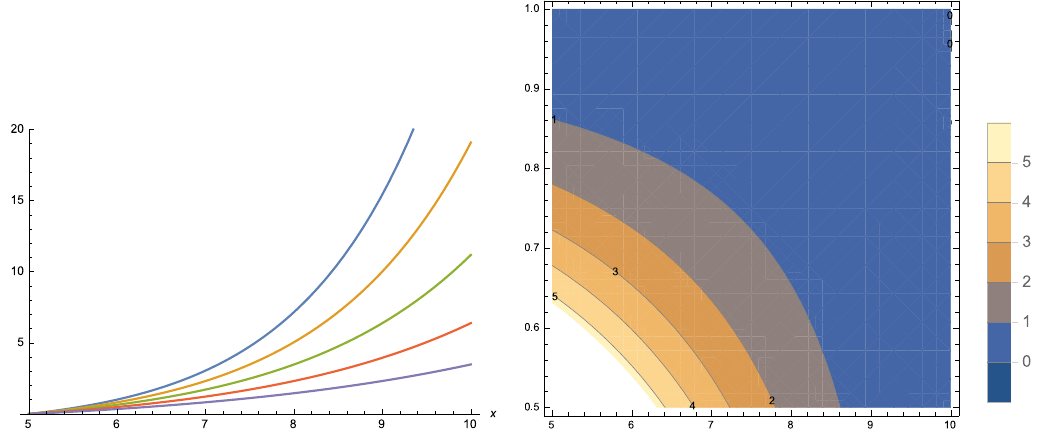
Figure 3. With reference to Example 2, left : plot of R t ( x ) for 5 < x < 10, with t = 5 and θ = 0.3, 0.4, 0.5, 0.6, 0.7 (from top to bottom); right : contour plot of R t ( x ) for 0.5 < θ < 1 and 5 < t < 10, with x =